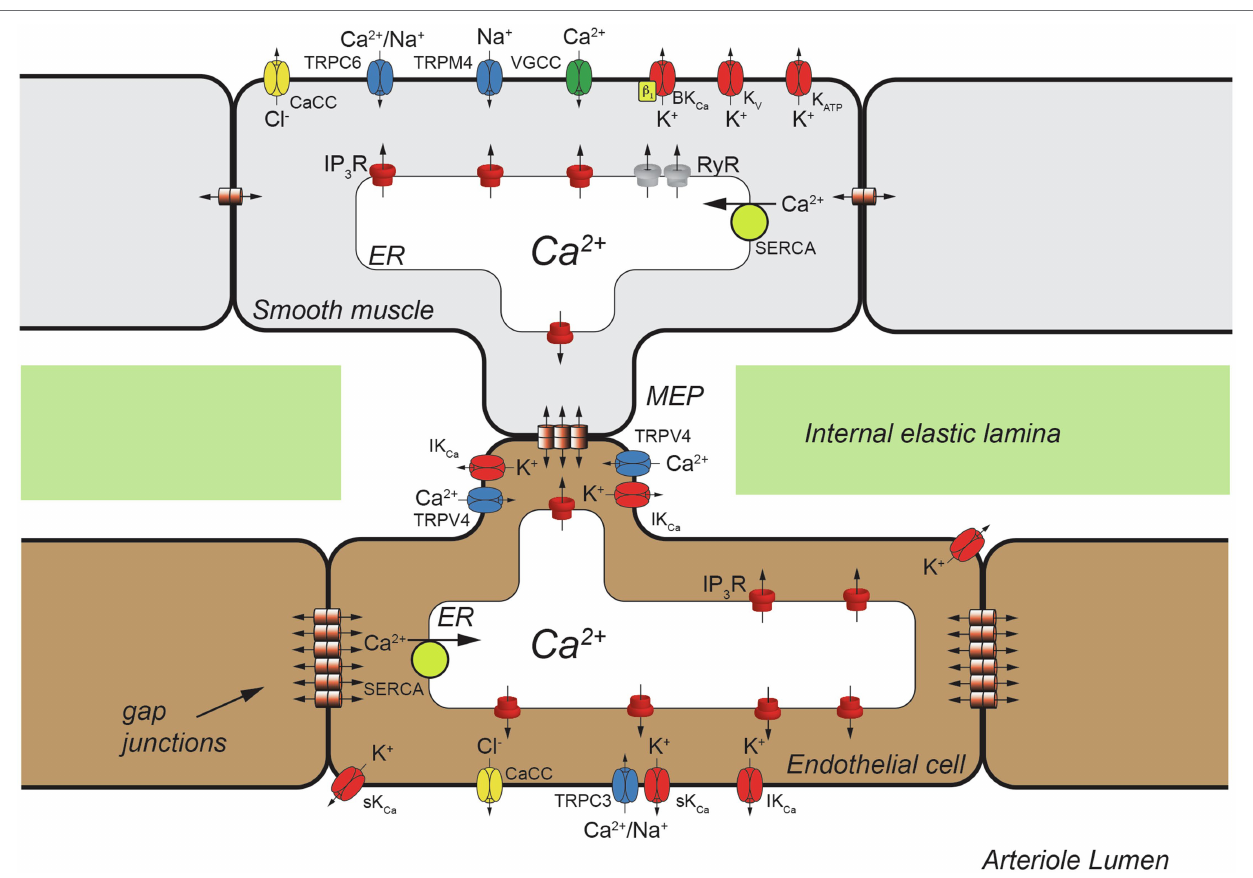
FIGURE 1 | Schematic representation of a cross section of one wall of an arteriole showing a myoendothelial projection (MEP) passing through a hole in the internal elastic lamina (IEL). Heterocellular gap junctions are present allowing electrical and chemical (Ca 2+ , IP 3 , etc.) communication between ECs and VSMCs. Also shown are homocellular (EC-EC and VSMC-VSMC) gap junctions that also allow electrical and chemical communication as shown. Only a few classes of ion channels expressed by arteriolar VSMCs and ECs are shown for clarity. TRPC6, transient receptor potential channel C family member 6; CaCC, Ca 2+ -activated Cl − channels; TRPM4, transient receptor potential channel melanostatin family member 4; VGCC, voltage-gated Ca 2+ channels, BK Ca , large-conductance Ca 2+ -activated K + channels; K V , voltage-gated K + channels; K ATP , ATP-sensitive K + channels; IP 3 R, inositol 1,4,5 trisphosphate receptor; RyR, ryanodine receptor; SERCA, smooth endoplasmic reticulum Ca 2+ ATPase; IK Ca , intermediate-conductance Ca 2+ -activated K + channel; TRPV4, Transient Receptor Potential Vanilloid-family 4 channels; TRPC3, transient receptor potential channel C family member 3; sK Ca , small-conductance Ca 2+ -activated K +